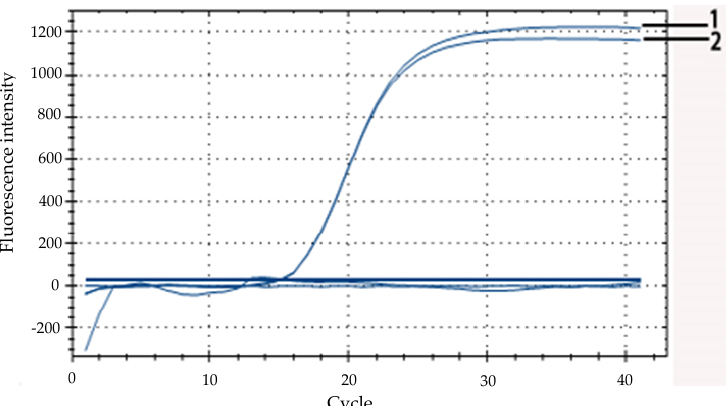
Figure 2. Validation of the e ff ectiveness of the target gene probe. The curves 1 and 2 represent two parallel experiments to verify the validity of the TaqMan probes.